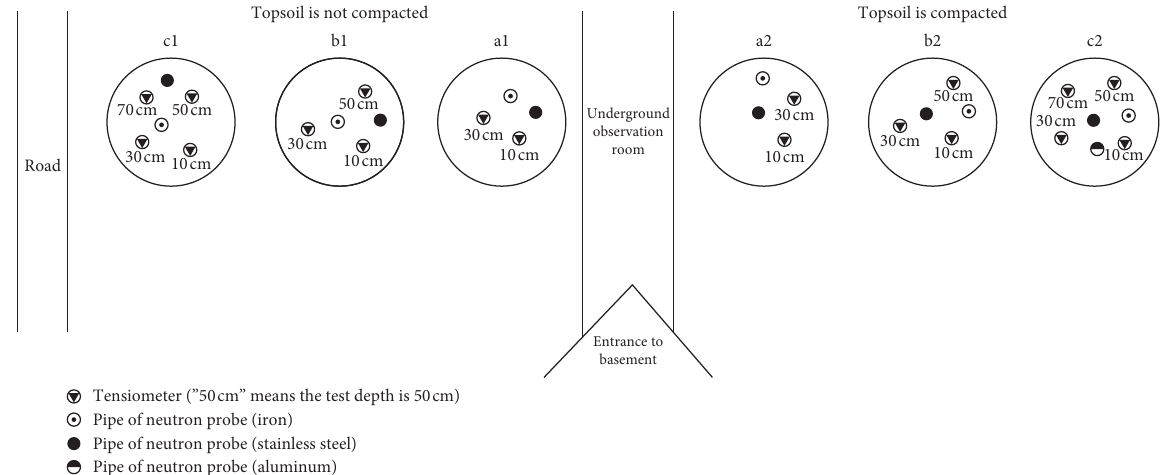
Figure 2: Layout chart of tensiometers and neutron probes.